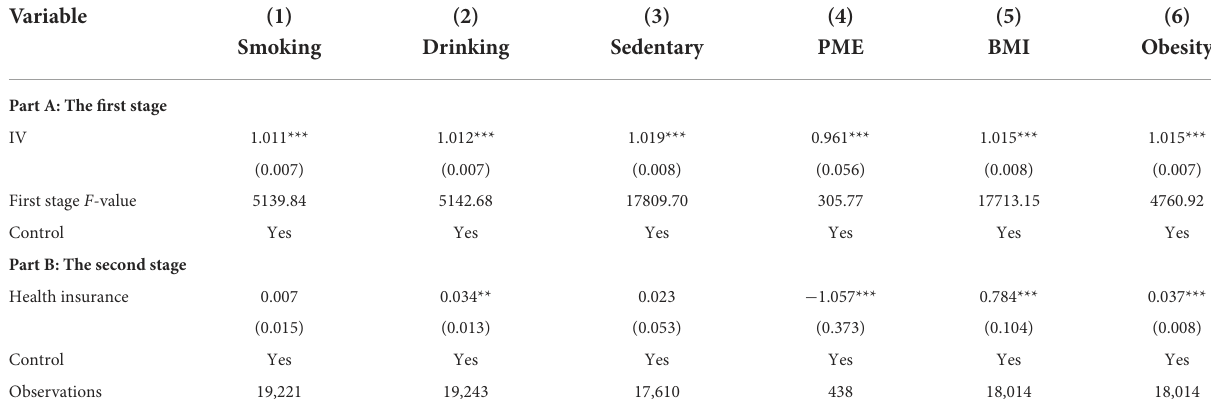
TABLE 4 Instrumental variable regression results.